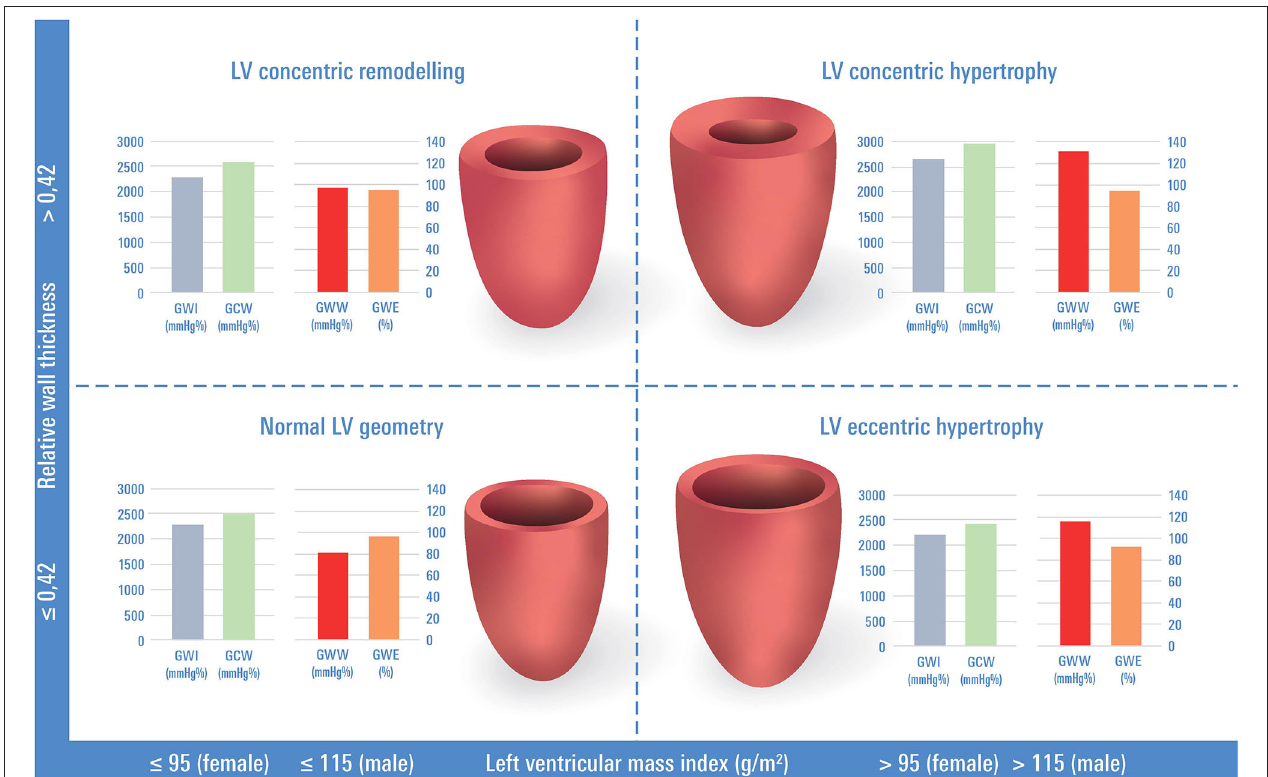
FIGURE 1 | Classification of left ventricular geometry based on the left ventricular mass index and relative wall thickness and myocardial work indices. Columns with myocardial work indices represent the mean or median values of our study sample. GWI, global work index; GCW, global constructive work; GWW, global wasted work, GWE, global work